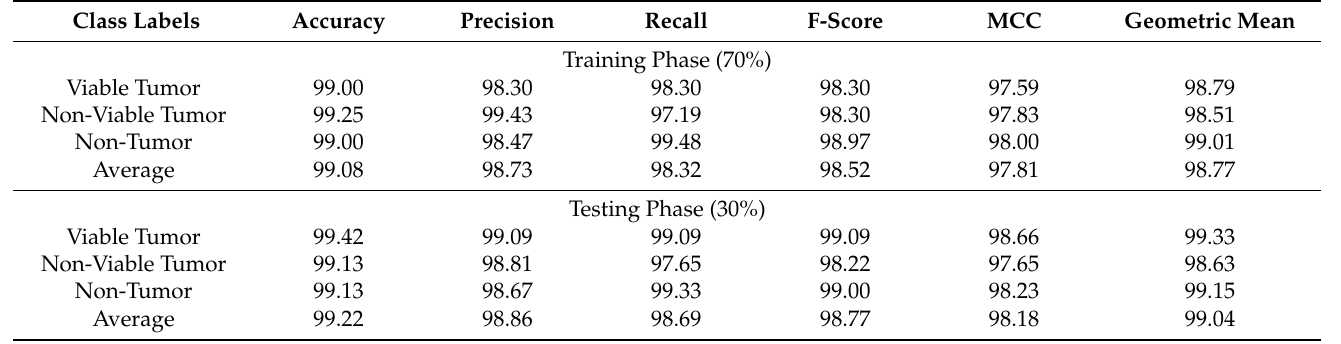
Table 2 and Figure 6 demonstrate the detailed classifier outcomes of the WDODTL- ODC algorithm with TR data of 80% and TS data of 20%. The results outperformed that the WDODTL-ODC algorithm has effectually categorized the images with maximal outcomes. Table 2. Result analysis of WDODTL-ODC technique with various measures under 70% of TR and 30% of TS data.